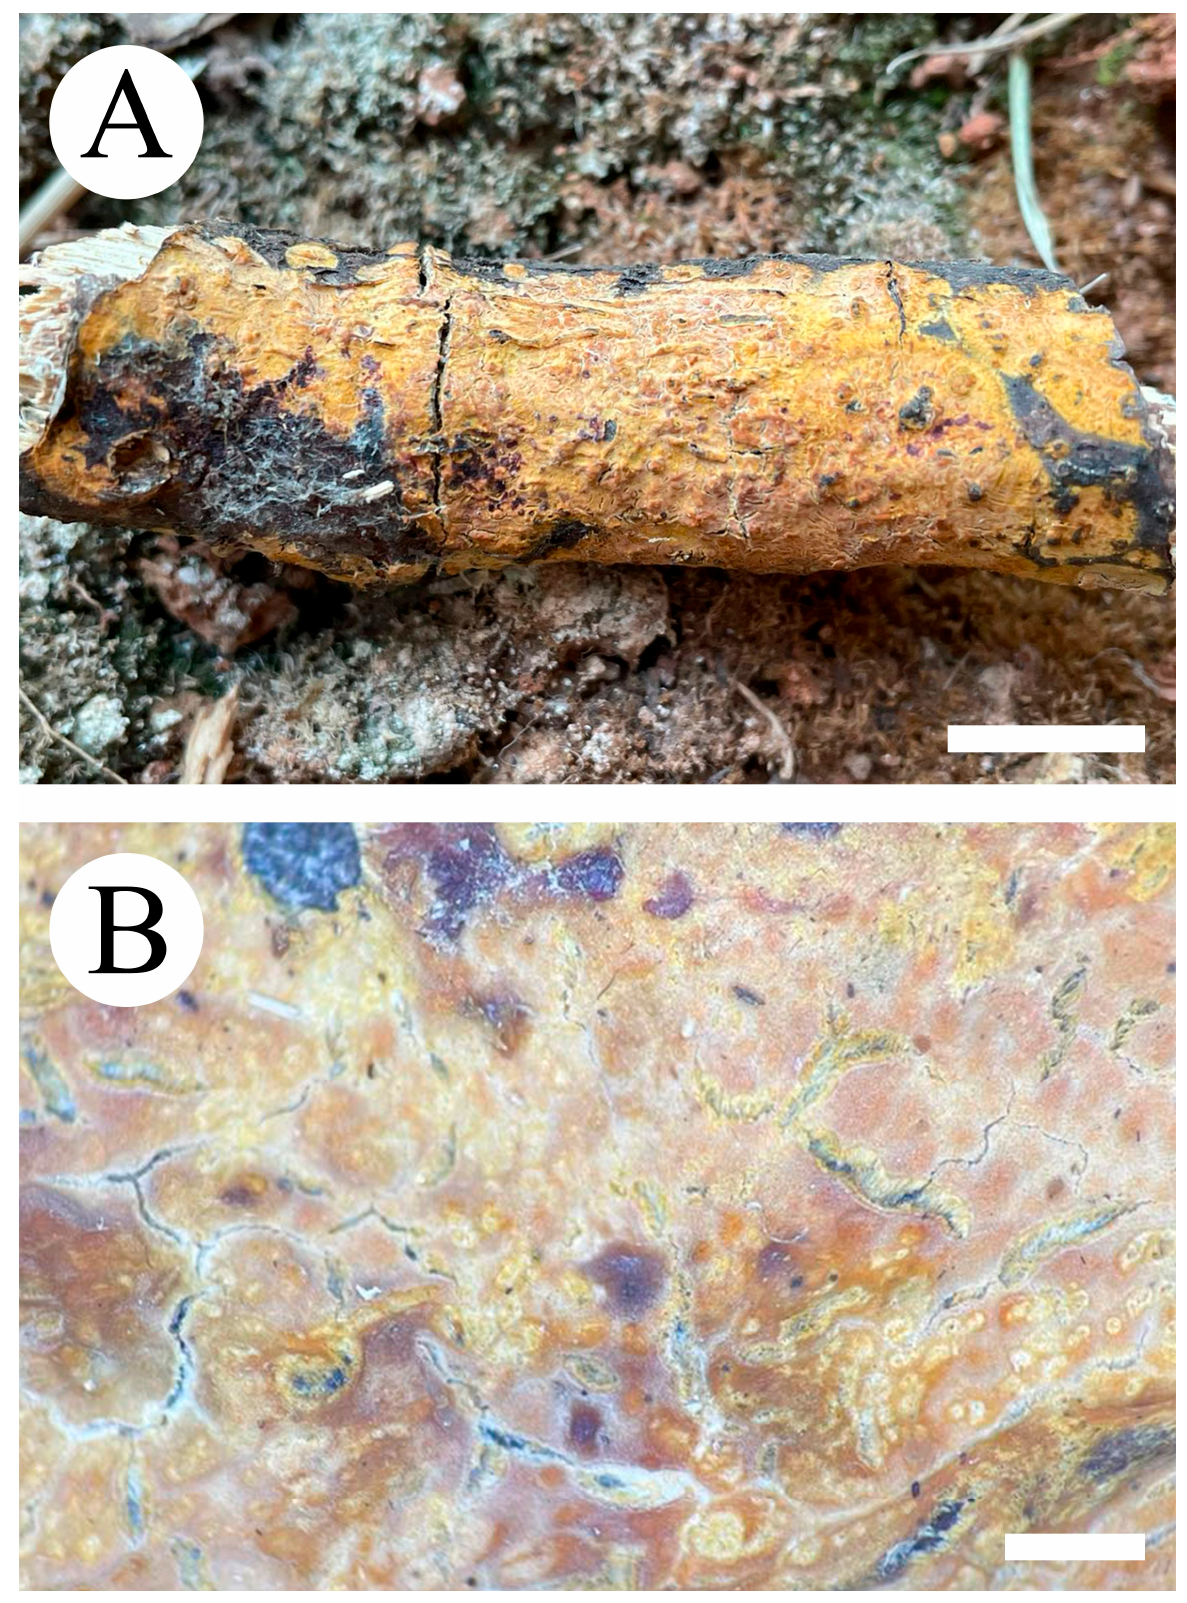
Figure 3. Basidioma of Crustodontia rhododendri (CLZhao 6168, holotype). Bars: ( A ) = 1 cm, ( B ) = 1 mm.